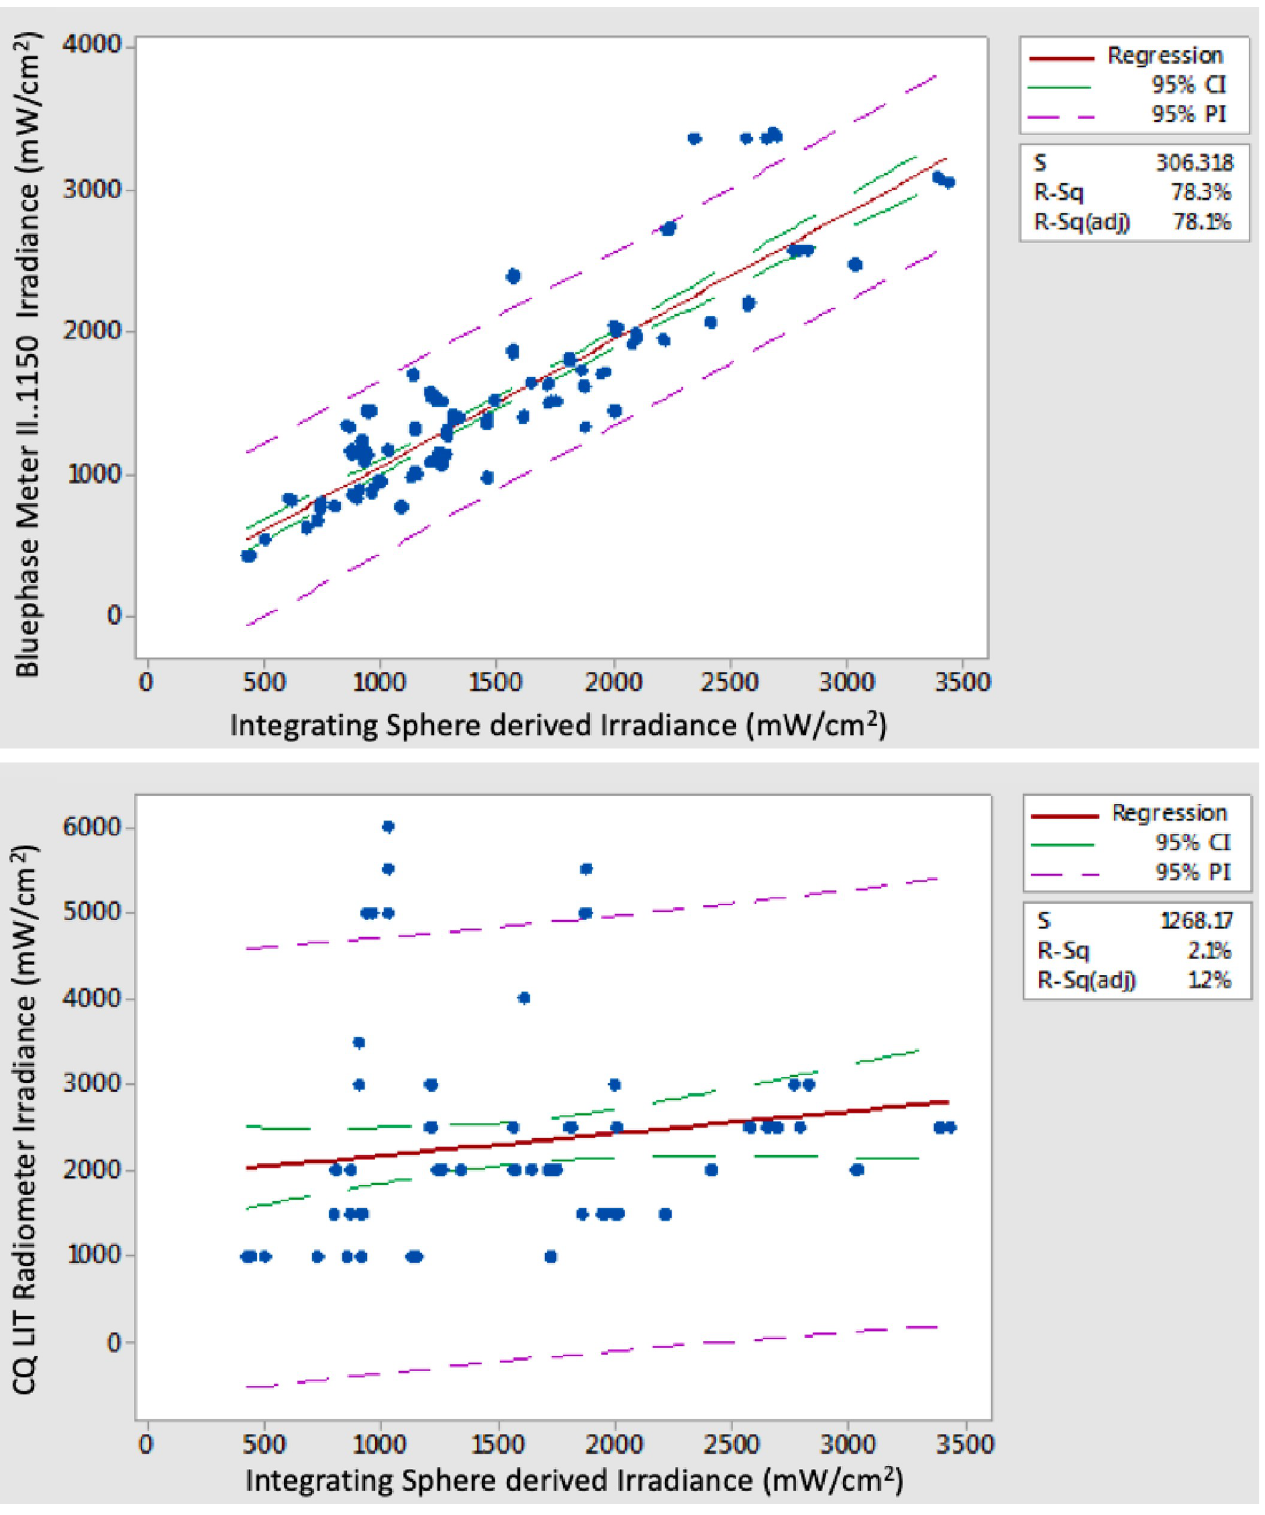
Fig 3. Regression analysis fitted line plots comparing irradiance data for the (a) BMII (sn:1300001150) and (b) the CQ LIT radiometer with the corresponding Integrating Sphere derived irradiance data sets as the independent variable.